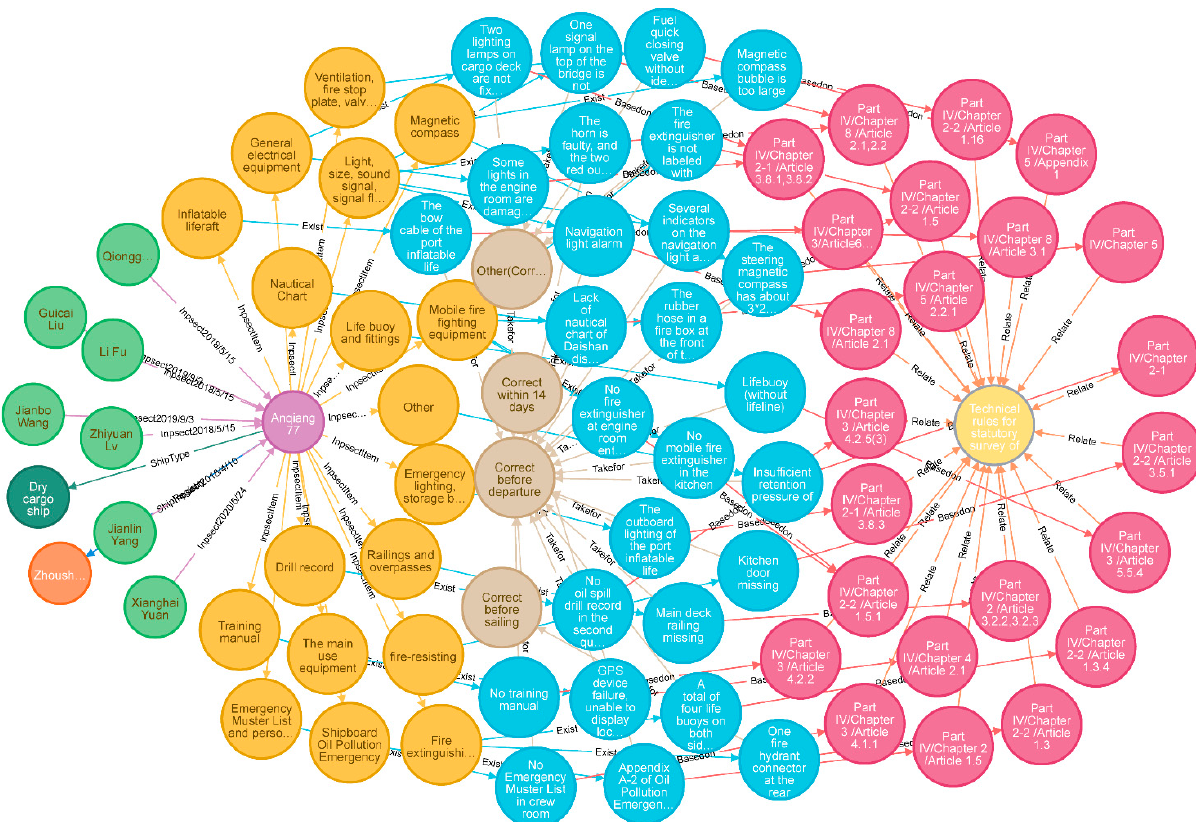
Figure 8. Ship FSC inspection knowledge graph (part).